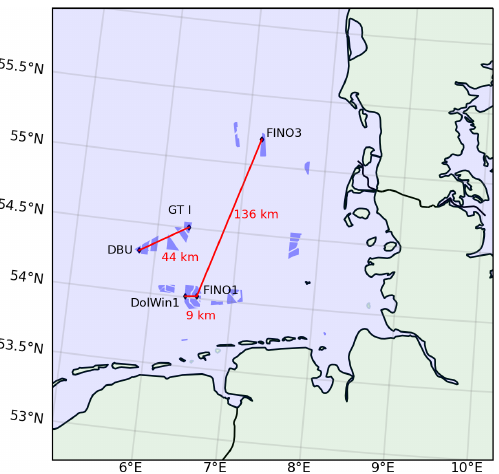
Figure 1. Different scales in the German Bight: intra-cluster scale: DolWin1 and FINO1; inter-cluster scale: Deutsche Bucht (DBU) and Global Tech I (GT I); and German Bight scale: FINO1 and FINO3. For the evaluation, the NEWA grid points closest to the selected sites were taken. The wind farms that are currently opera- tional and under construction are marked in blue (data from Bunde- samt für Seeschifffahrt und Hydrographie, 2020). The coastline and border data originate from the Natural Earth dataset (Natural Earth,